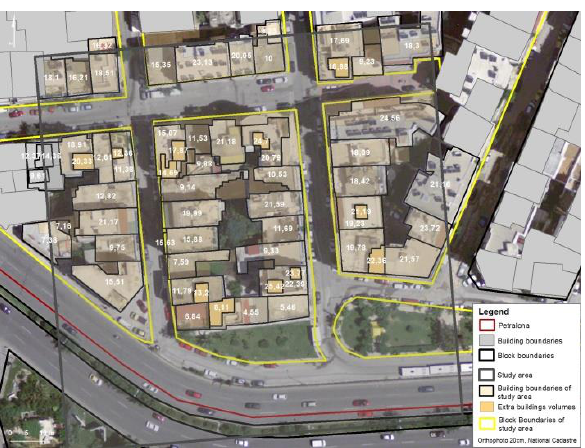
Figure 1: Building Heights of